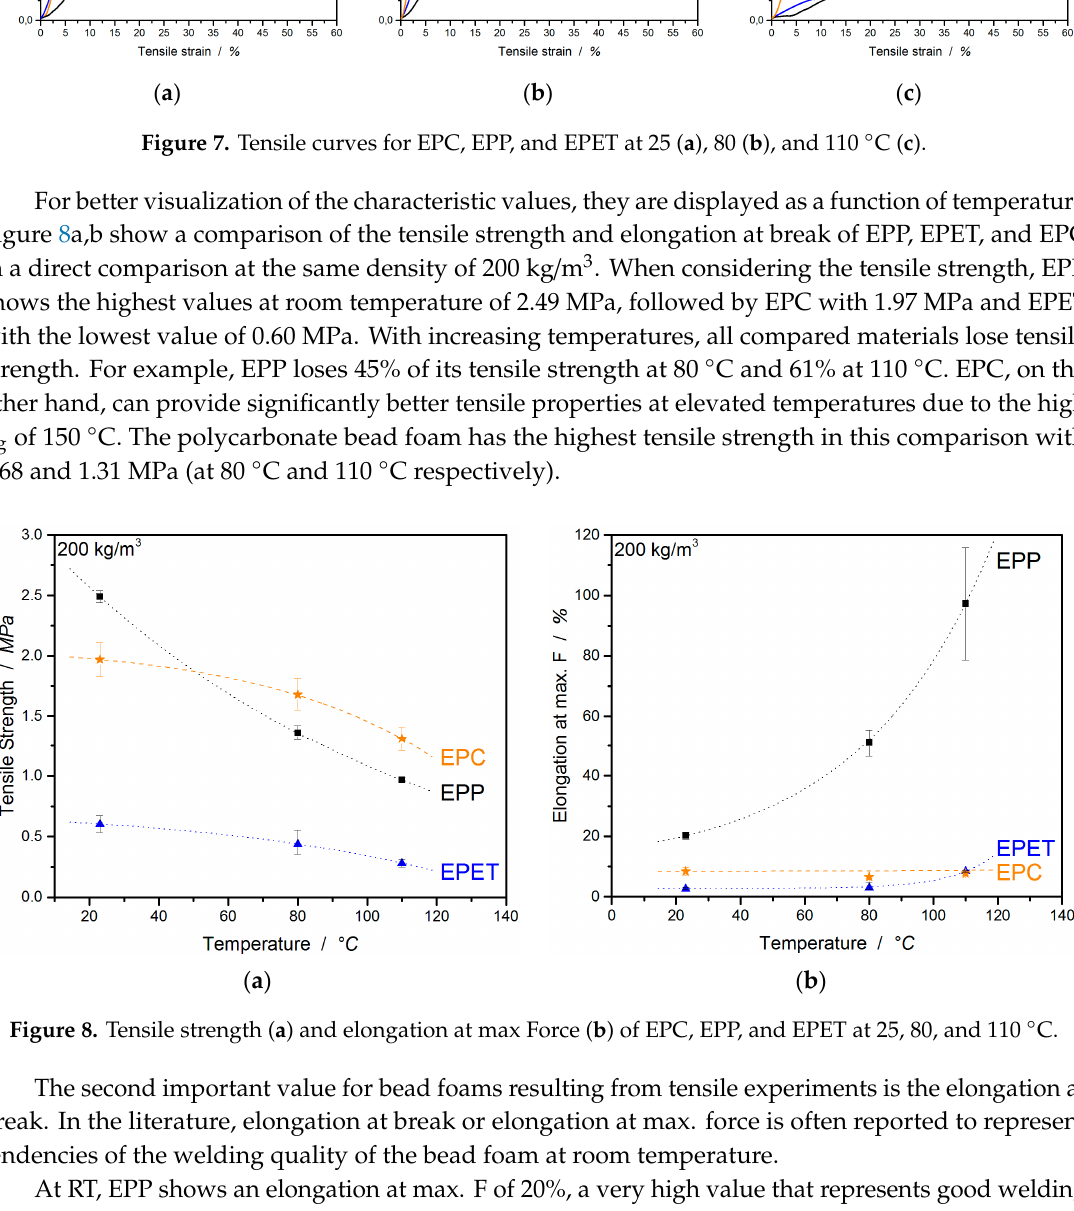
Table 3. Comparison of elongation at max. F and tensile strength of EPC, EPP, and EPET. EPC